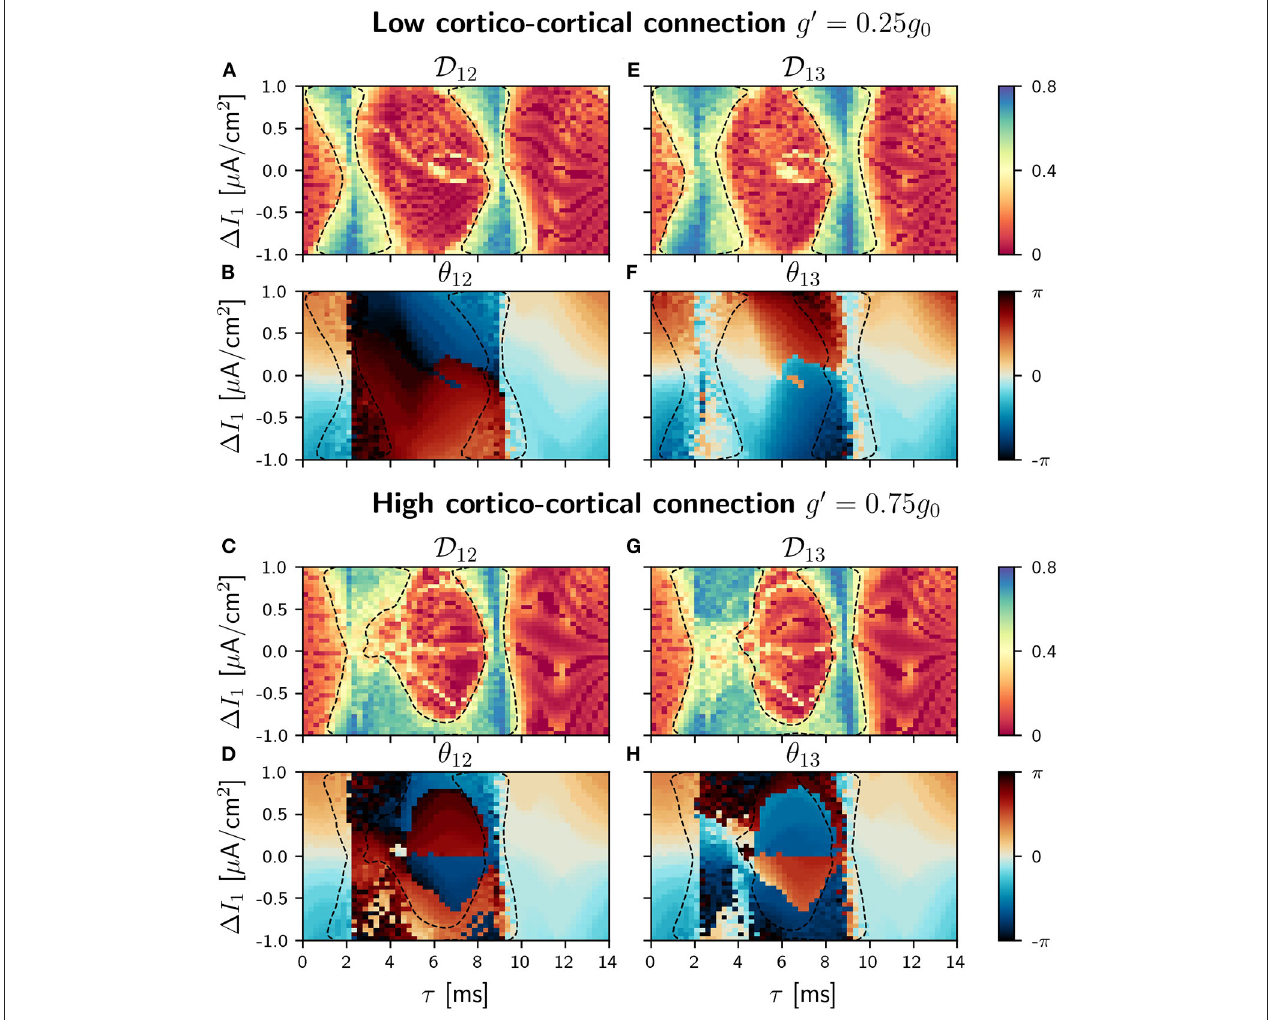
0.25 g 0 (A,E) and g ′ 0.75 g 0 (C,G) . Phase difference θ ij for g ′ = =